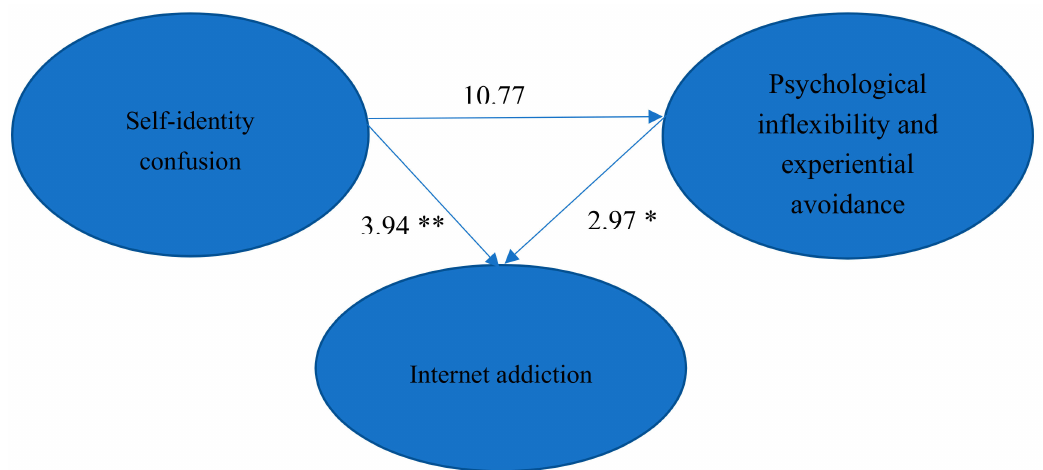
Figure 2. The estimated coe ffi cients of the paths in the hypothesized model for the relationships among self-identity confusion, Internet addiction, and PI / EA. (* p < 0.05; ** p <